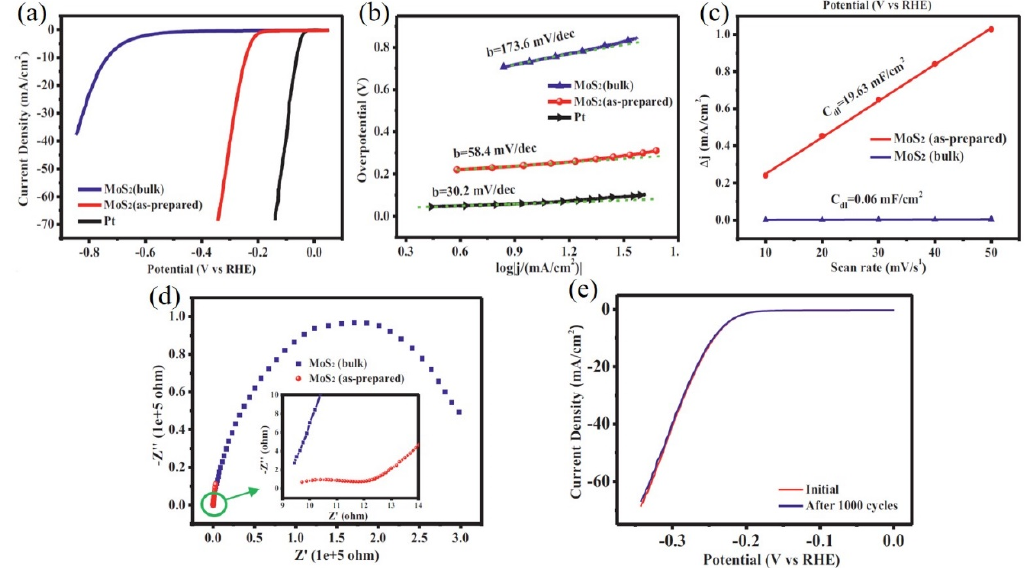
Figure 18. ( a ) Polarization curves and ( b ) Tafel slopes of bulk MoS 2 (blue line), as-prepared MoS 2 monolayer (red line), and Pt (black line), respectively. ( c ) The double-layer capacitances C dl of bulk MoS 2 (blue line), as-prepared MoS 2 monolayer (red line), ( d ) Nyquist diagrams of bulk MoS 2 (blue square), as-prepared MoS 2 monolayer (red dot) measured at 300 mV overpotential, and ( e ) the polarization durability test of the as-prepared MoS 2 monolayer (red line: Initial state, blue line: After 1000 cycles) [48]. Table 3. The S 2p and Mo 3d XPS peak parameters of the as-prepared MoS 2 monolayer